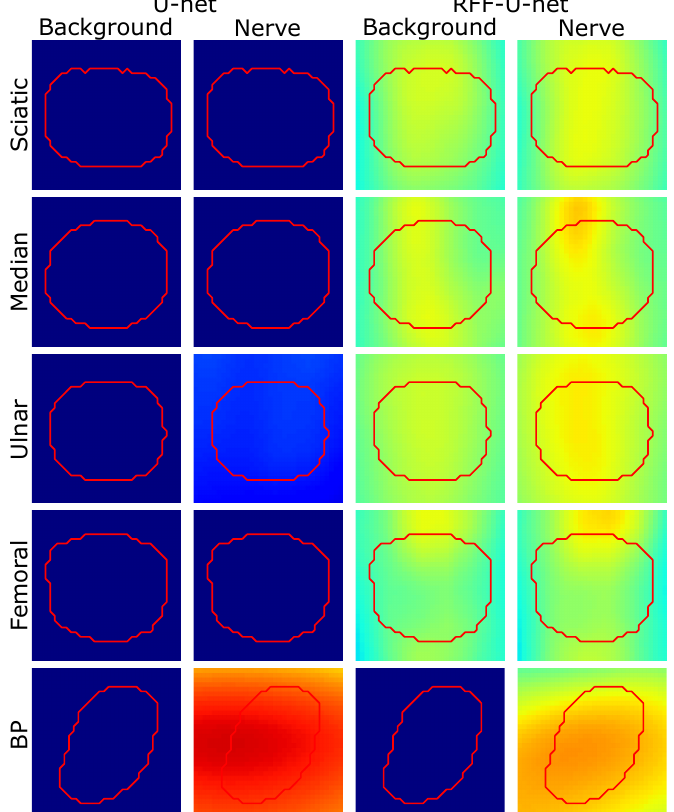
Figure 8. Region of interest-based relevance analysis results for Unet and RFF-Unet approaches (Nerve-UTP and NSD datasets). Red contour: median target segmentation region (rescaled and centered for visualization) along with the testing set instances. Heatmaps are presented on a Jet colormap scale, where the blue color stands for low relevance, yellow for medium relevance, and red for high